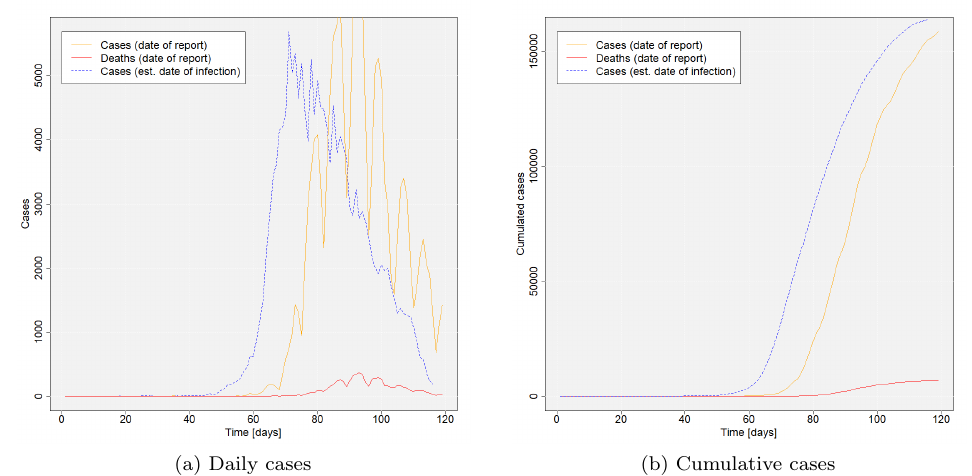
Figure 3: Reported SARS-CoV-2 infections in Germany over time (dates of report vs. estimated dates of infection)